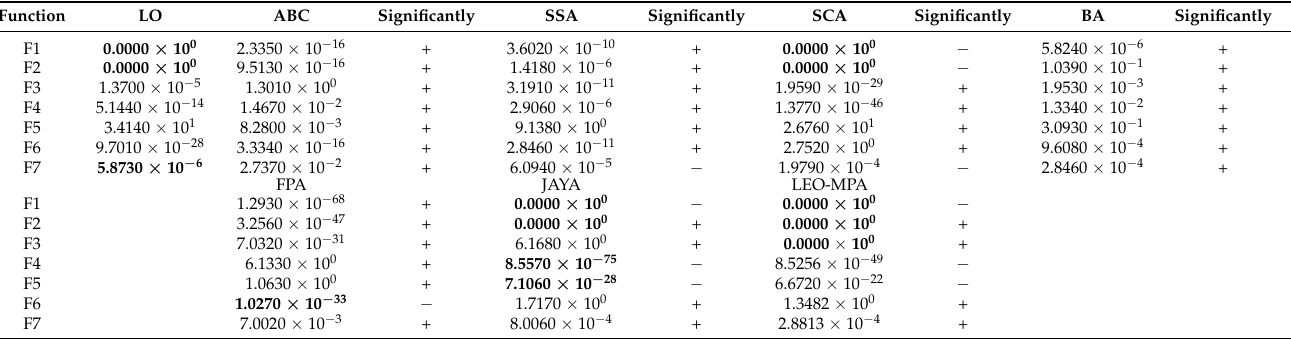
Table 5. Comparative performance of the LO algorithm with swarm algorithms based on functions